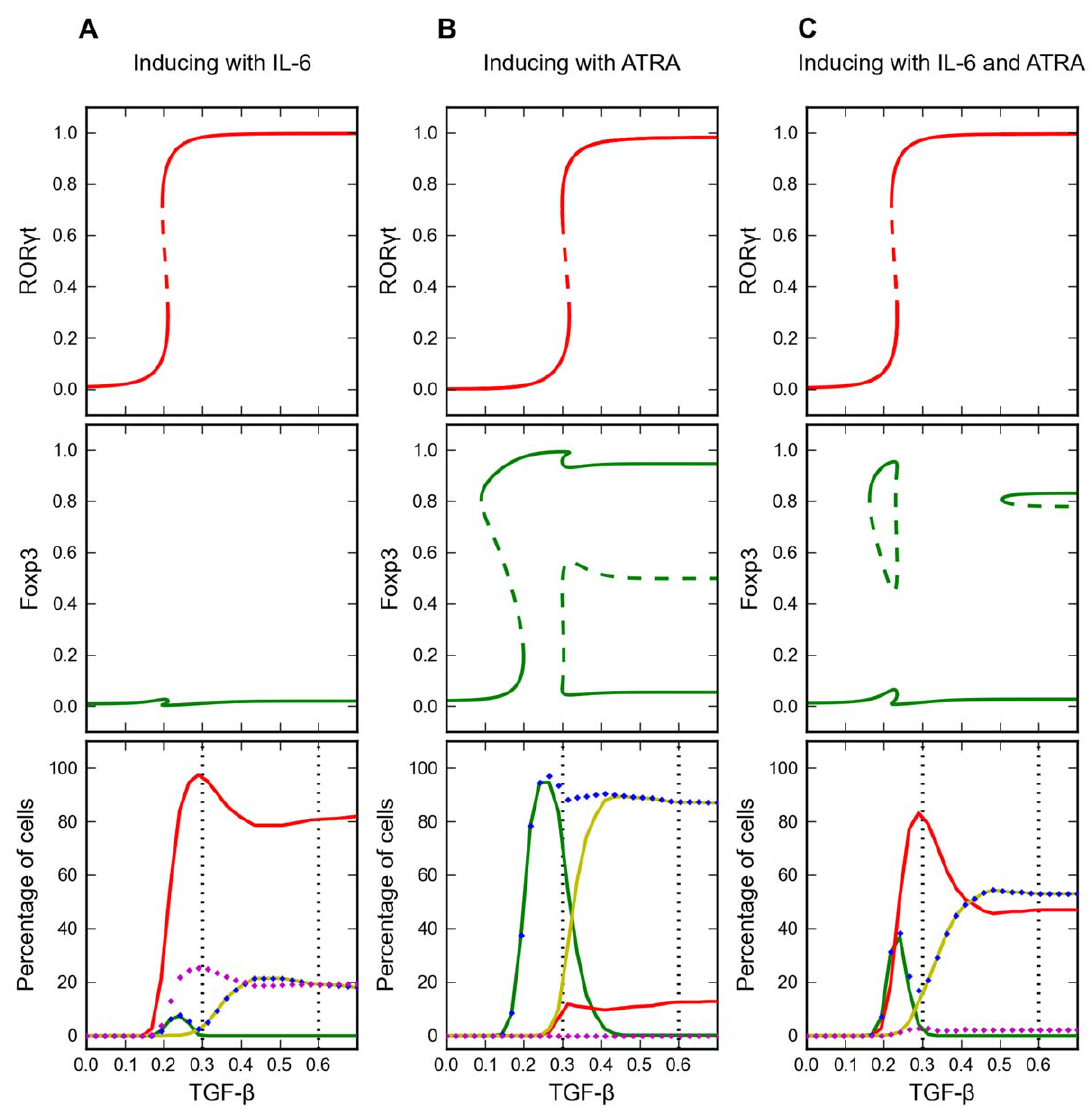
Figure 5. Effects of polarizing signals on the induced differentiation. Simulation of the asymmetric model (Figure 1C). Upper and middle panels: one-parameter bifurcation diagrams for the average cell. ROR c t and Foxp3 steady state levels are plotted as functions of TGF- b concentration. See the legend to Figure 3 for the interpretation of the curves. A. Cells treated with [IL-6]=10 units together with the indicated amount of TGF- b . B. Cells treated with [ATRA]=1.5 units together with the indicated amount of TGF- b . C. Cells treated with [IL-6]=10 units and [ATRA]=1.5 units together with the indicated amount of TGF- b .